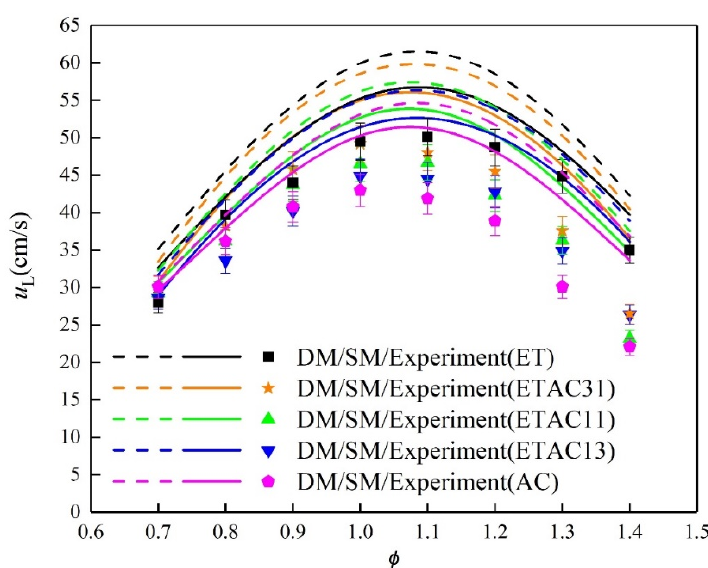
Figure 7. Experimental and numerical laminar burning velocities of the fuel blend of ethanol and acetone at an initial temperature of 358 K and pressure of 0.1 MPa.